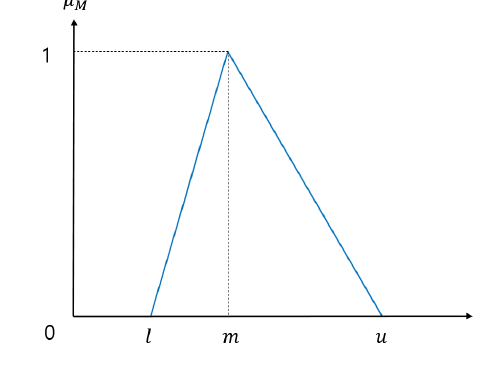
Figure 4. Fuzzy number. Table 4. Fuzzified Satty’s Scale for Triangular Fuzzy